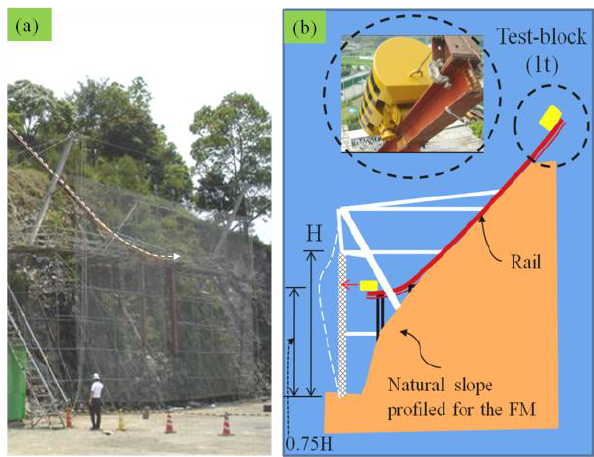
Fig. 2. The FM set up in the LPR test campaign. (a) : a picture taken from the FM test site in Kochi, Japan (2008.5.27). (b) : sec- tional side view illustrating the test set-up. Picture of cylindrical block used in the test is also shown. This block is released from a predefined height at the top of the rail, and traversing along the ideally frictionless rail, it hits the net at the specified point (0.75H in the